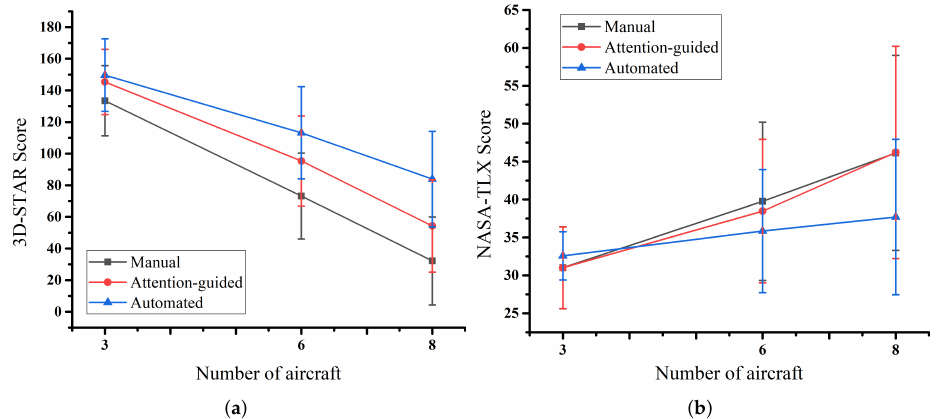
Figure 9. Statistical results on SA and workload. ( a ) 3D-SART scale score, ( b ) NASA-TLX scale